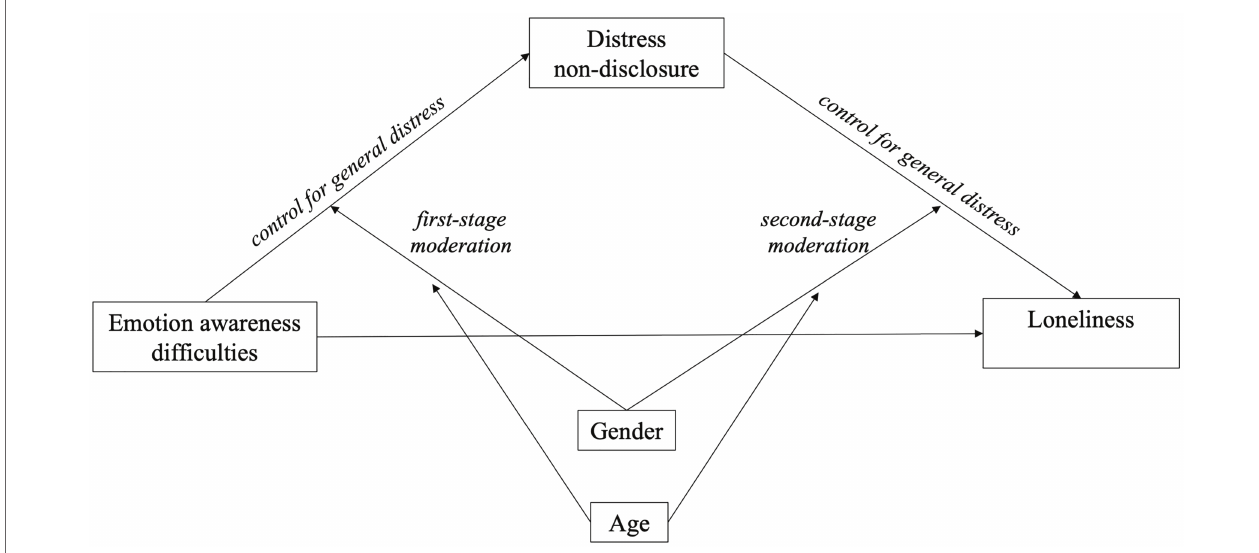
FIGURE 1 | Illustration of conditional process analysis examining distress concealment as mediator of emotional awareness and